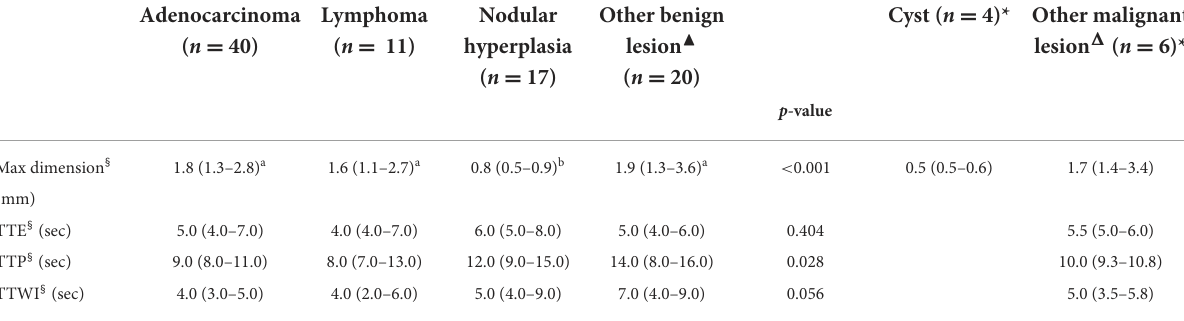
TABLE 3 Quantitative CEUS wash-in features of the lesions, along with cytopathological